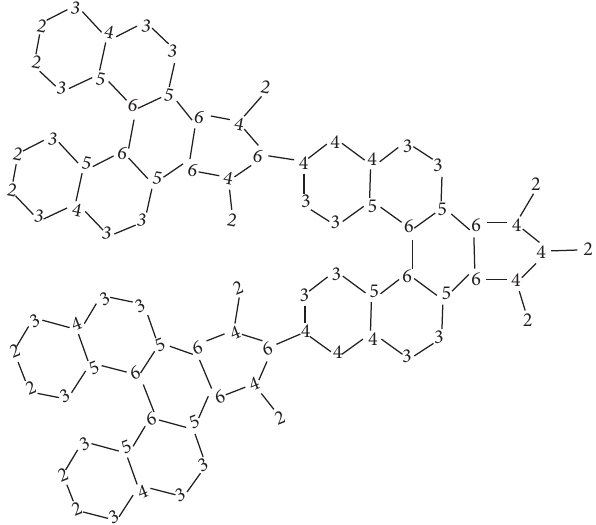
Figure 8: D [ 2 ] along with the CN of each 2